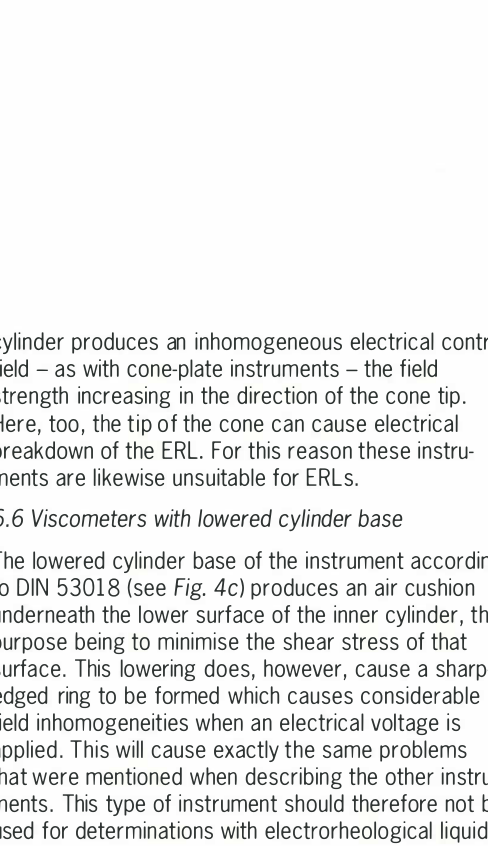
Fig. 5: Flow curves for an ERL when subjected to steady electrical fields {determined using a Haake CV 20 ER rotational